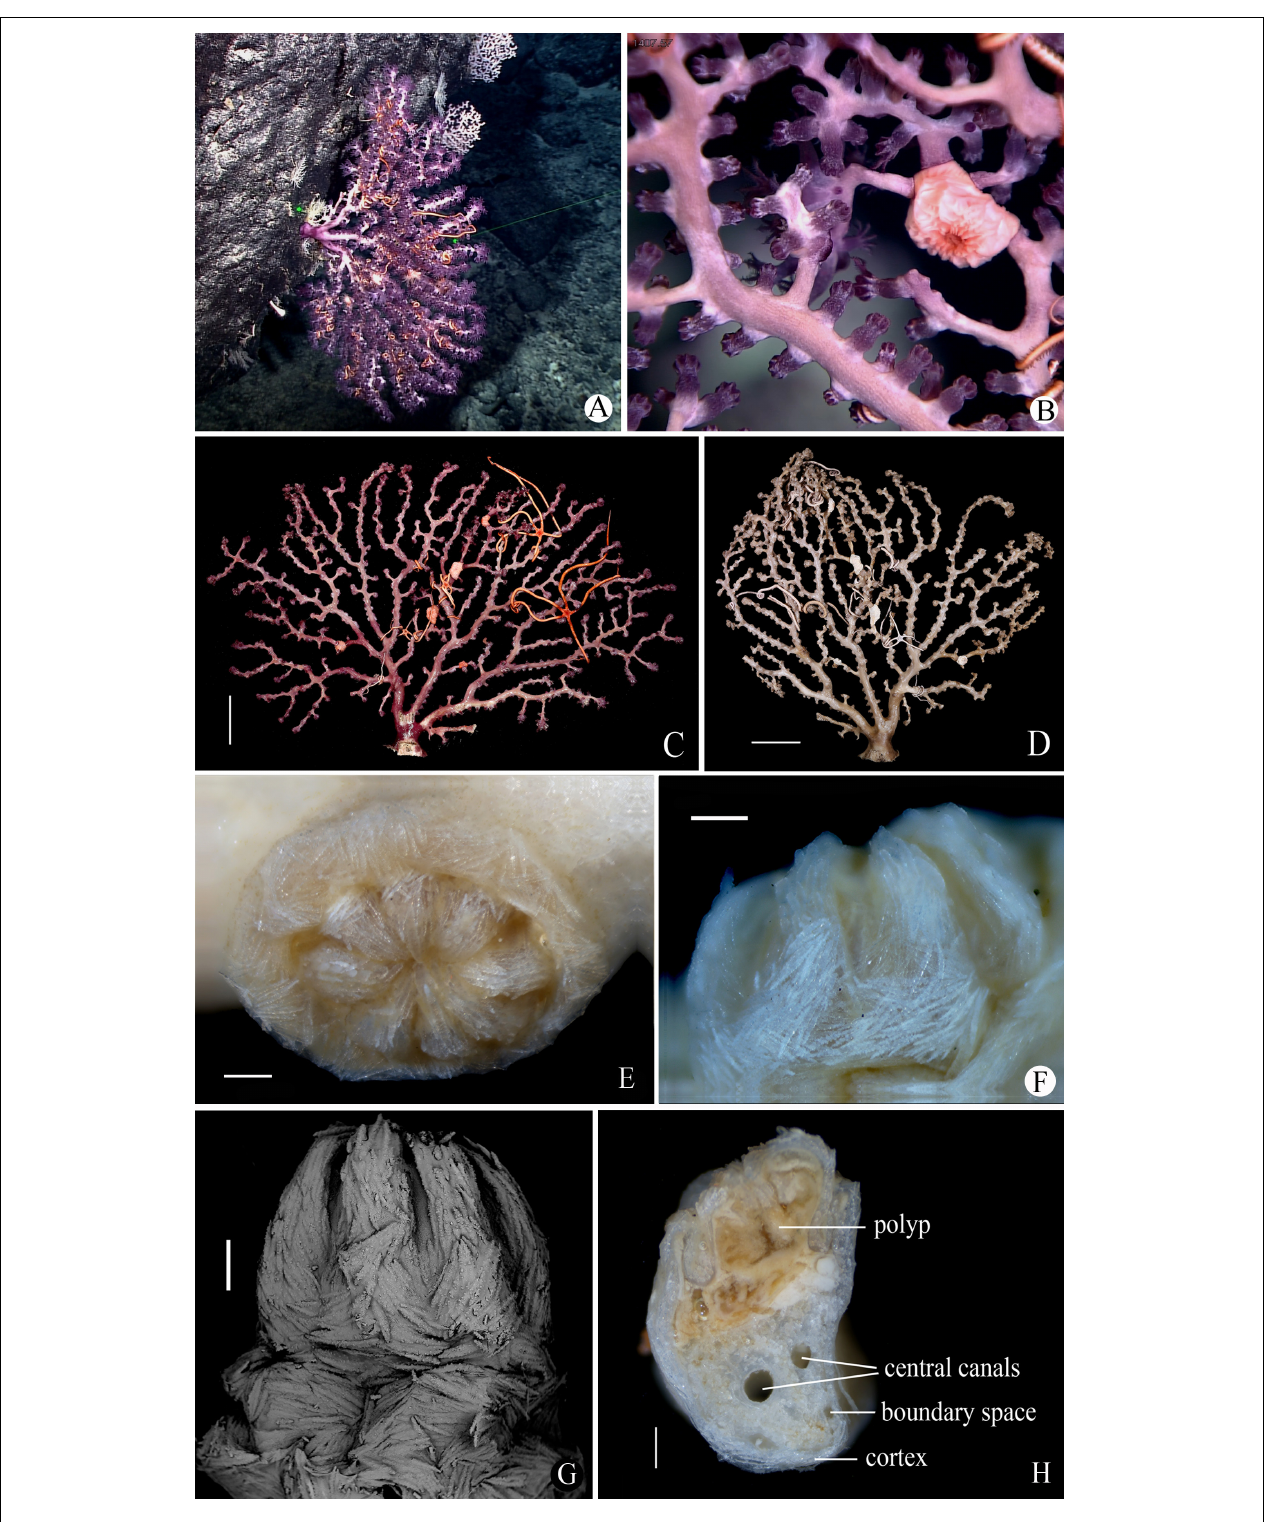
FIGURE 7 | Morphology of Victorgorgia flabellata sp. nov. (A) In situ . Laser dots spaced at 33 cm used for measuring dimensions. (B) Close view in situ , showing expanded polyps. (C) The side of the freshly collected holotype with fewer autozooids, photographed by Shaoqing Wang. (D) The side with more autozooids in preservation. (E) A retracted autozooid. (F,G) Lateral view of polyp head. (H) Cross-section of terminal medulla through a polyp. Scale bars = 5 cm (C,D) , and 0.5 mm (E–H) .